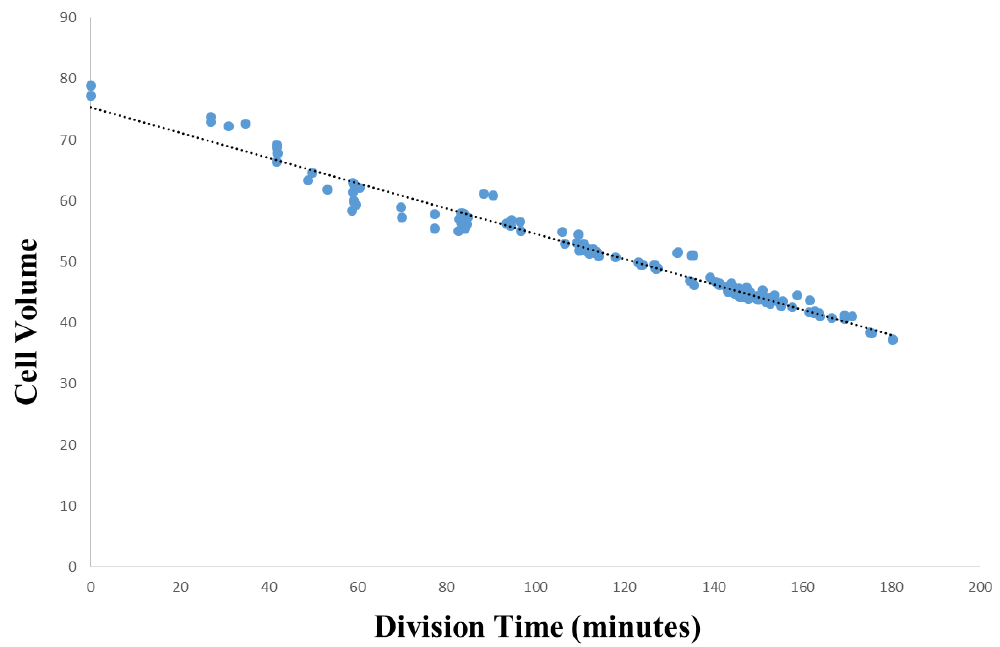
Figure 6. An analysis of cell volume in C. elegans versus lifetime (as calculated by Bao et al. [55]), based on 192 cells (N = 192) from a subtree of the AB lineage. Cell volume is extrapolated from nuclear diameter and is normalized as a percentage of total embryo volume Lifetime as in Figure 5. Trendline (black) is based on a linear function.